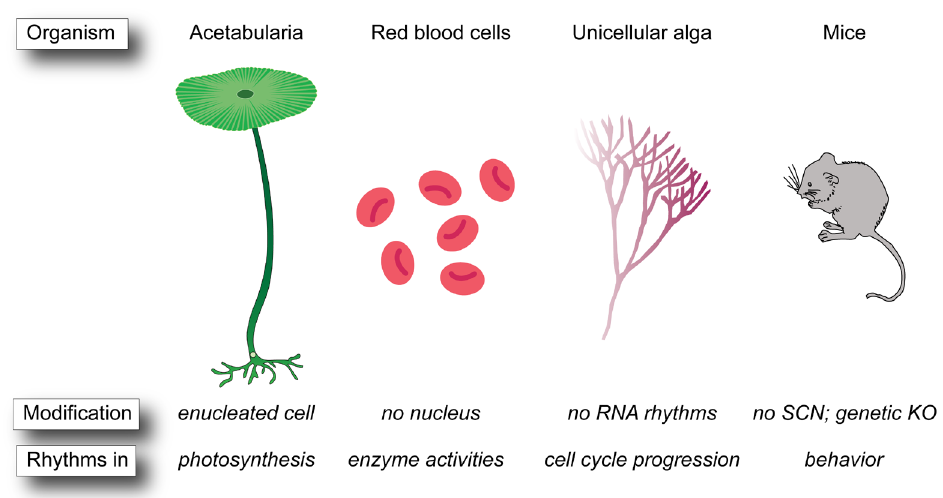
Figure 1. Post-translation oscillators without transcription-translation feedback loops. Examples of post-translation oscillators in enucleated cells such as Acetabularia and red blood cells, in unicellular alga lacking RNA rhythms, and in mice in which the classic transcription-translation feedback loop module is disrupted genetically or anatomically. KO, knockout; SCN, suprachiasmatic